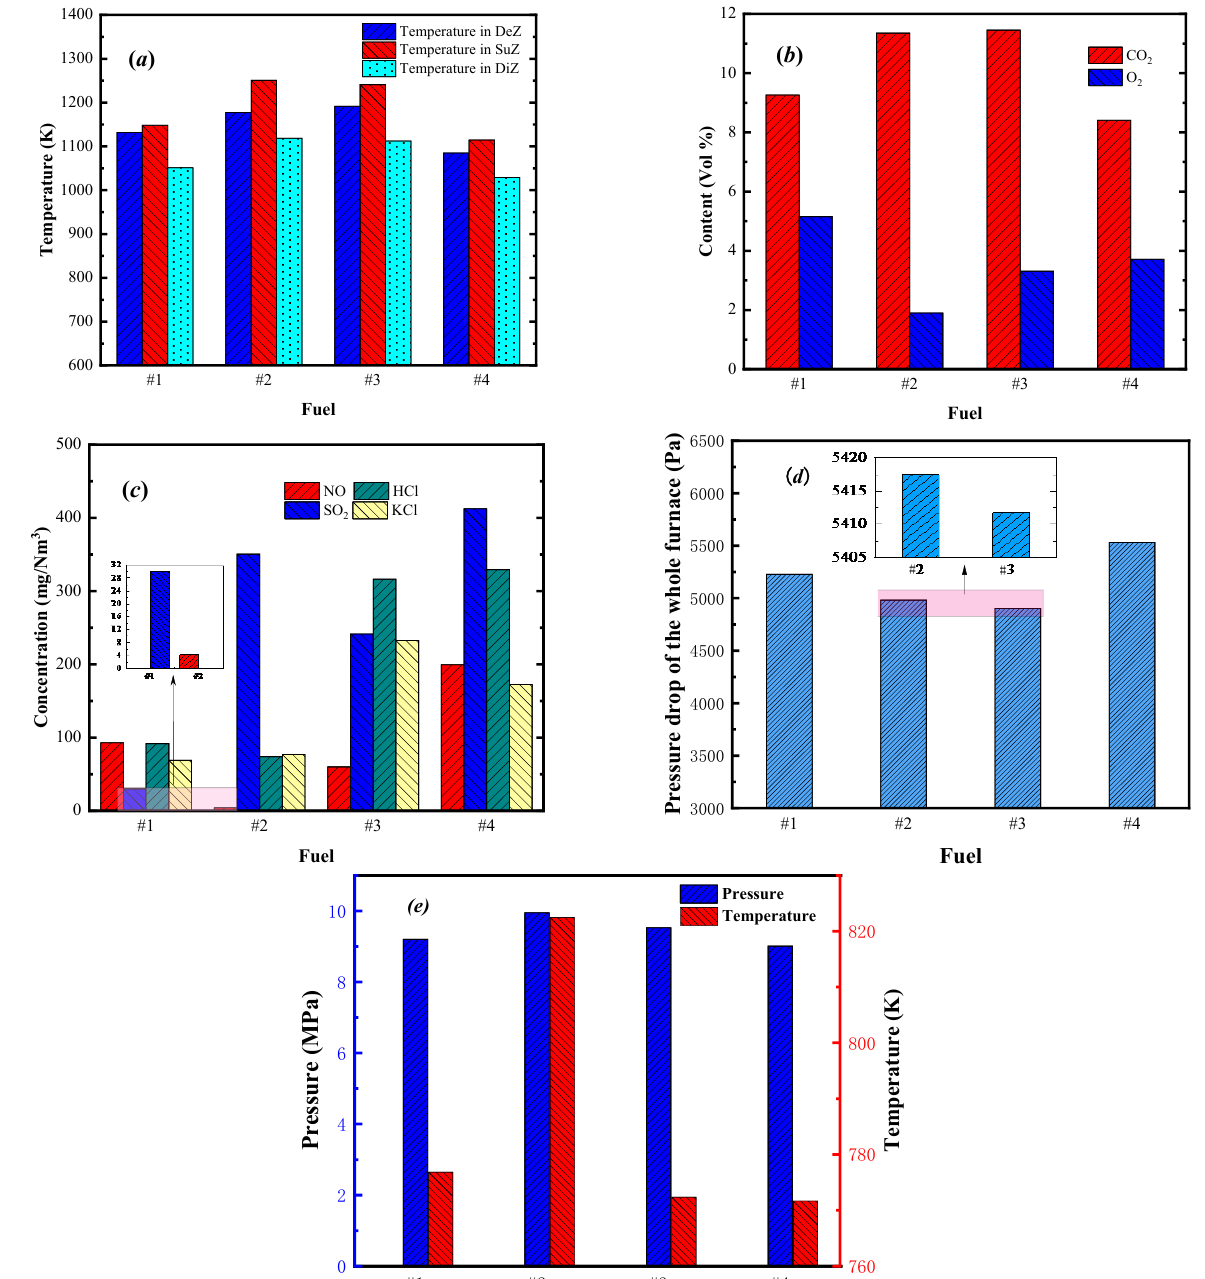
Figure 2. ( a ) furnace temperature distribution ( b ) O 2 , CO 2 volume fraction ( c ) pollution gas mass concentration ( d ) overall furnace pressure drop (air distributor to furnace outlet) ( e ) main steam pressure and temperature.